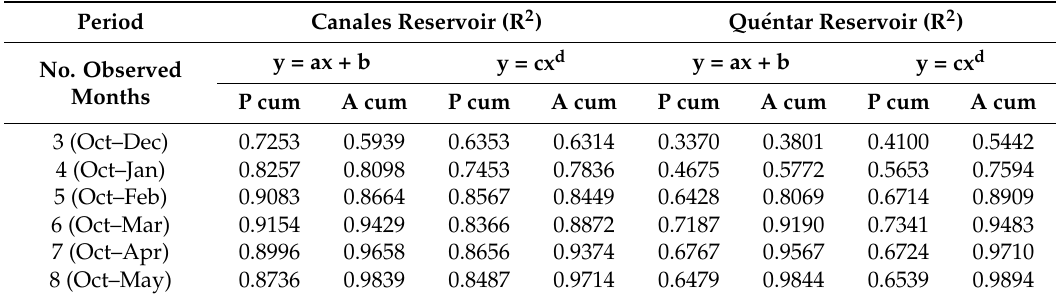
Table 2. Coefficient of determination (R 2 ) from the regression